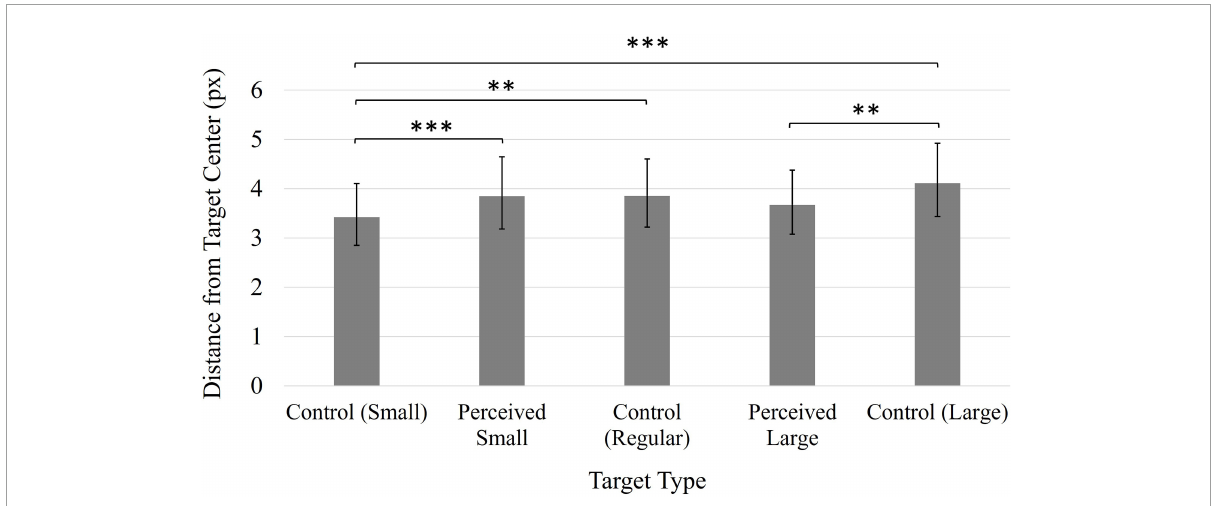
FIGURE1 Average distance from click position to target center. Values have been back-transformed into original measurement value (px). Smaller values indicate higher accuracy. Error bars represent 95% confidence intervals. ∗∗ p < 0.01, ∗∗∗ p < 0.001.